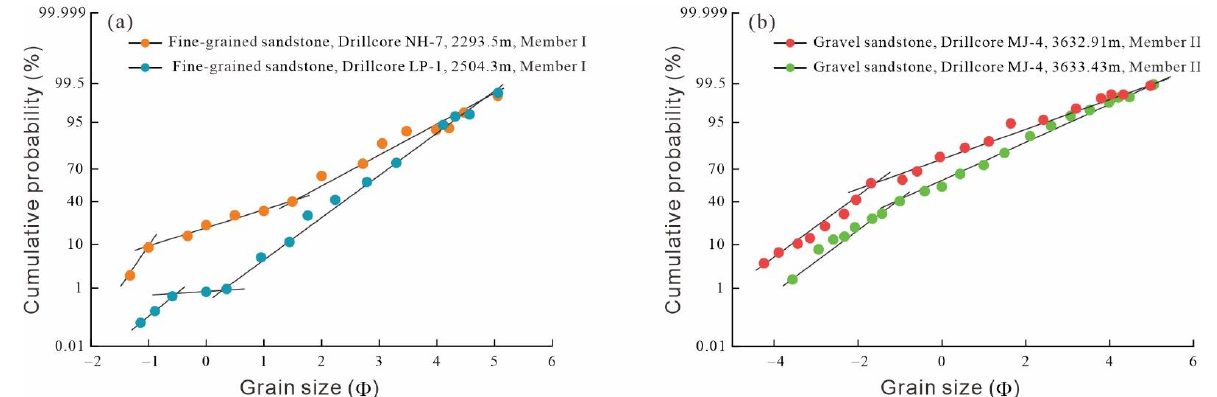
Figure 4. Particle size probability accumulation curve of the Jiucaiyuan Formation in the Beisantai area. ( a ) Characteristics of three-section type particle size accumulation curves. ( b ) Characteristics of two-section type particle size accumulation curves.